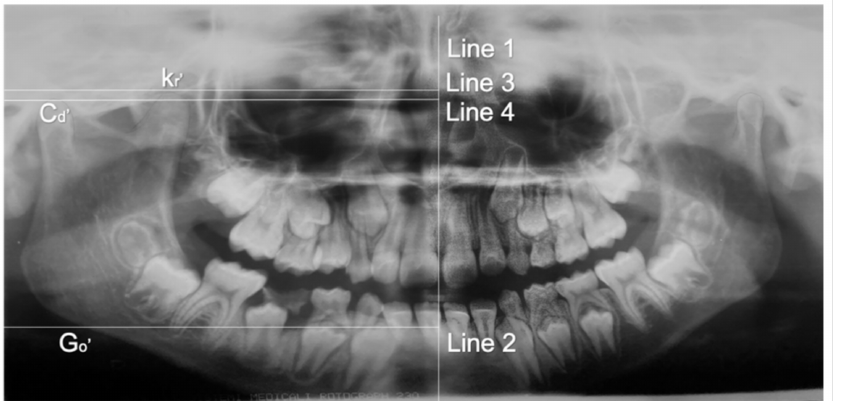
Figure 2. Diagram of the Levandoski panographic analysis on the panoramic X-ray. Line 1 is the maxillary vertical midline. Lines 2, 3 and 4 are perpendicular to line 1 as they cross the lower border of the symphysis of the mandible (Go (cid:48) ), the tip of the condyle (Cd (cid:48) ) and the tip of the coronoid process (Kr (cid:48) ), respectively (age 7).